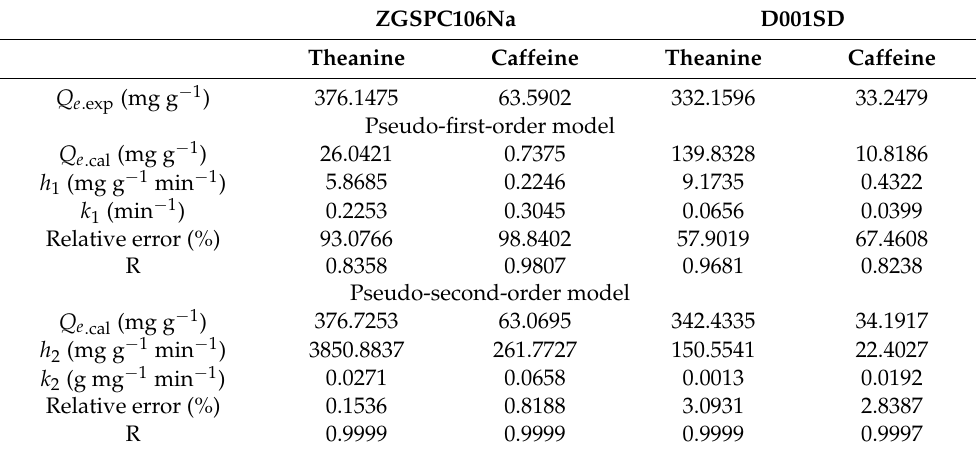
Table 3. Adsorption kinetic parameters of L-theanine and caffeine onto cation resins. ZGSPC106Na